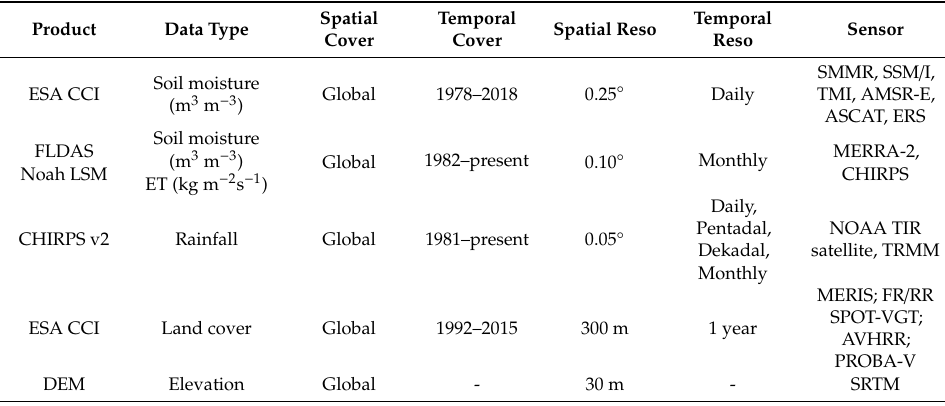
Table 1. Summary of the products used in this